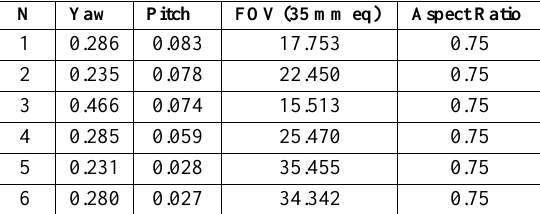
Table 2. Planar projection information